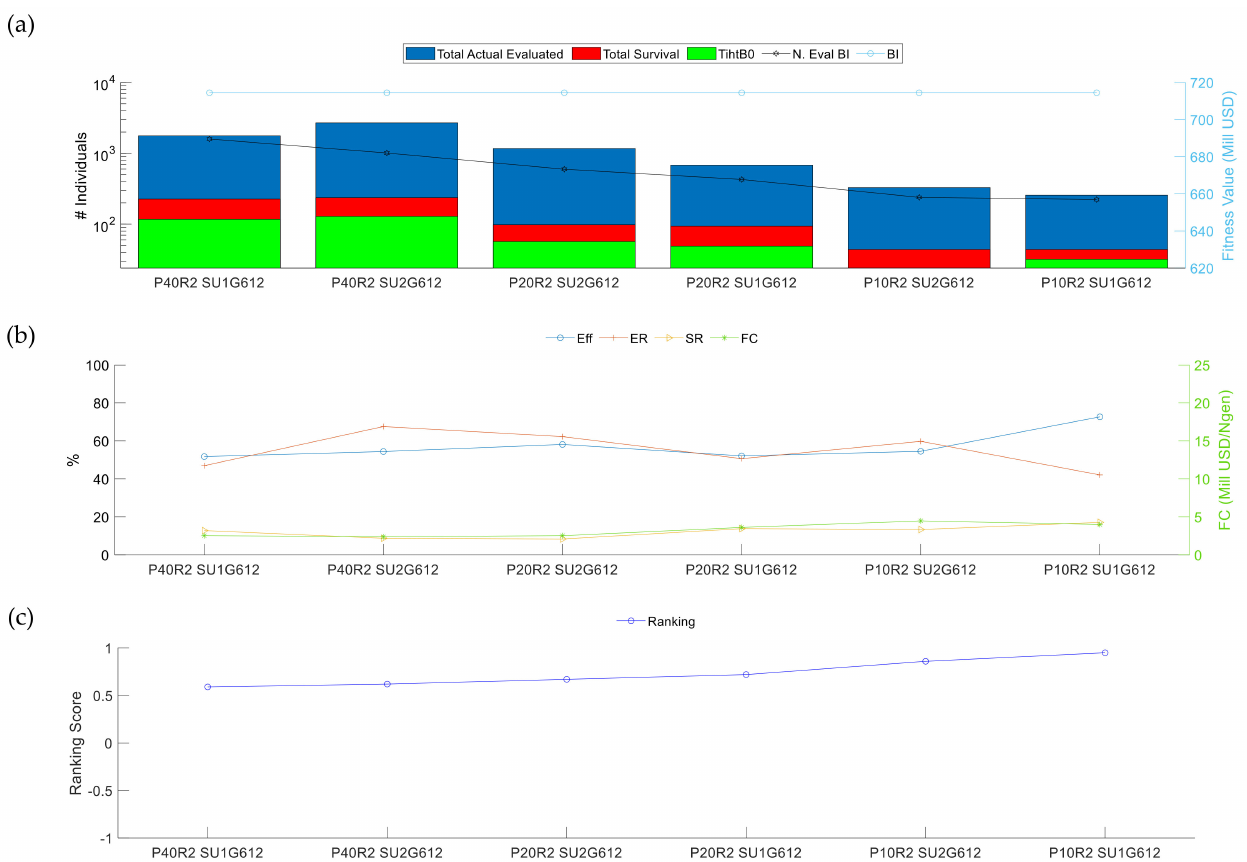
Figure 26. Summary of the performance indicators for the different populations sizes (POP xxR2). ( a ) shows variables of KPI 3,4 and 5 in bar chart, KPI 1 and variable of KPI 7 in line chart, ( b ) shows KPI 3,4,5 and 6 in line chart, ( c ) shows the ranking score based on Table